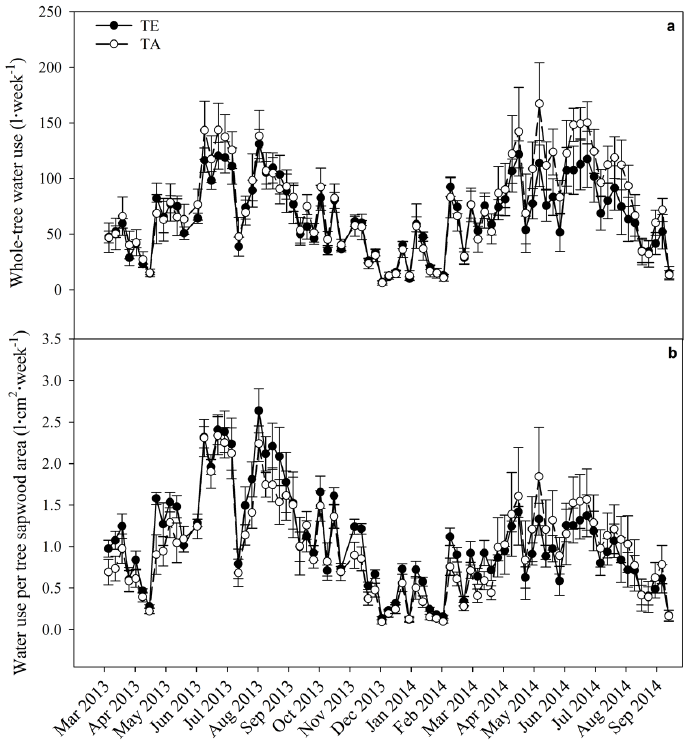
Figure 8. ( a ) Mean weekly total whole ‐ tree water use and ( b ) mean weekly total water use per sapwood area in response to 100% throughfall exclusion (TE) and ambient throughfall (TA) treatments ( n = 5).